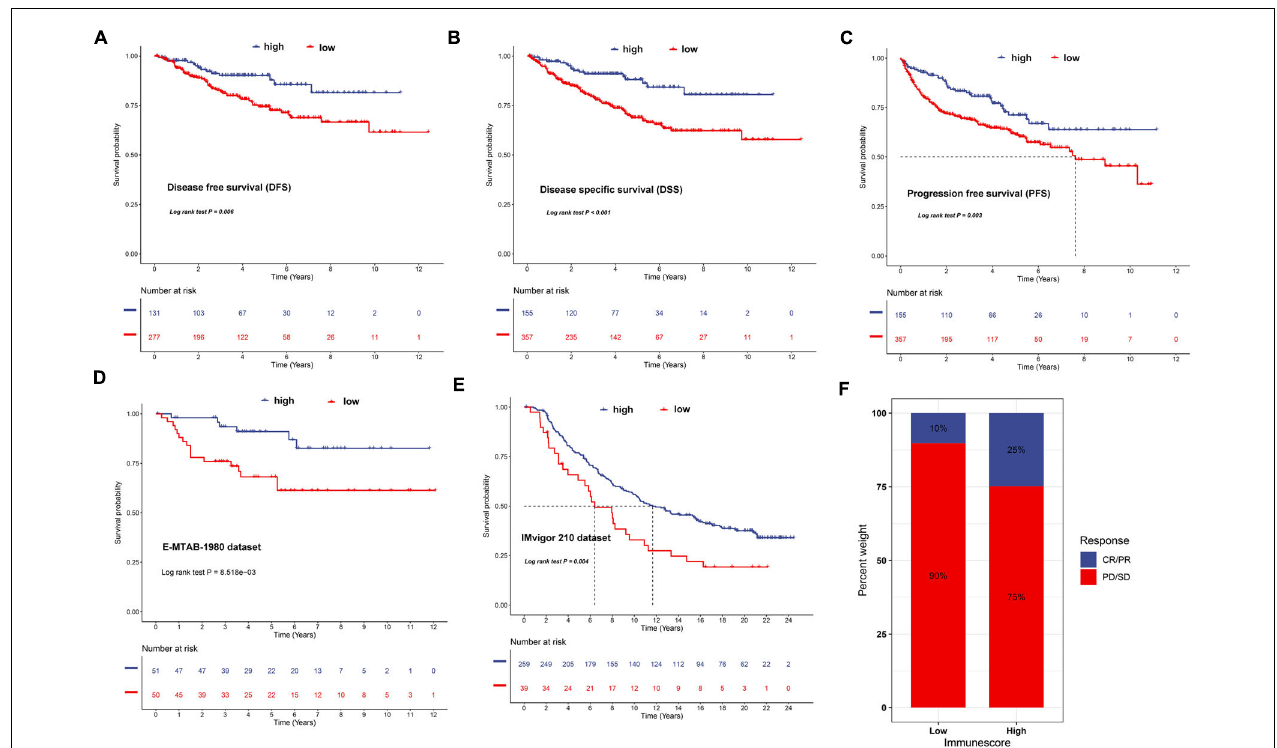
FIGURE 12 | Validation of the prognostic value of IR in disease-free survival (A) , disease-special survival (B) , and progression-free survival (C) of ccRCC, E-MTAB-1980 dataset (D) , and IMvigor210 cohort (E) , respectively. (F) The proportion of patients with response to PD-L1 blockade immunotherapy in low or high IR score groups. Responder/non-responder: 10%/90% in the low IR score groups and 25%/75% in the high IR score